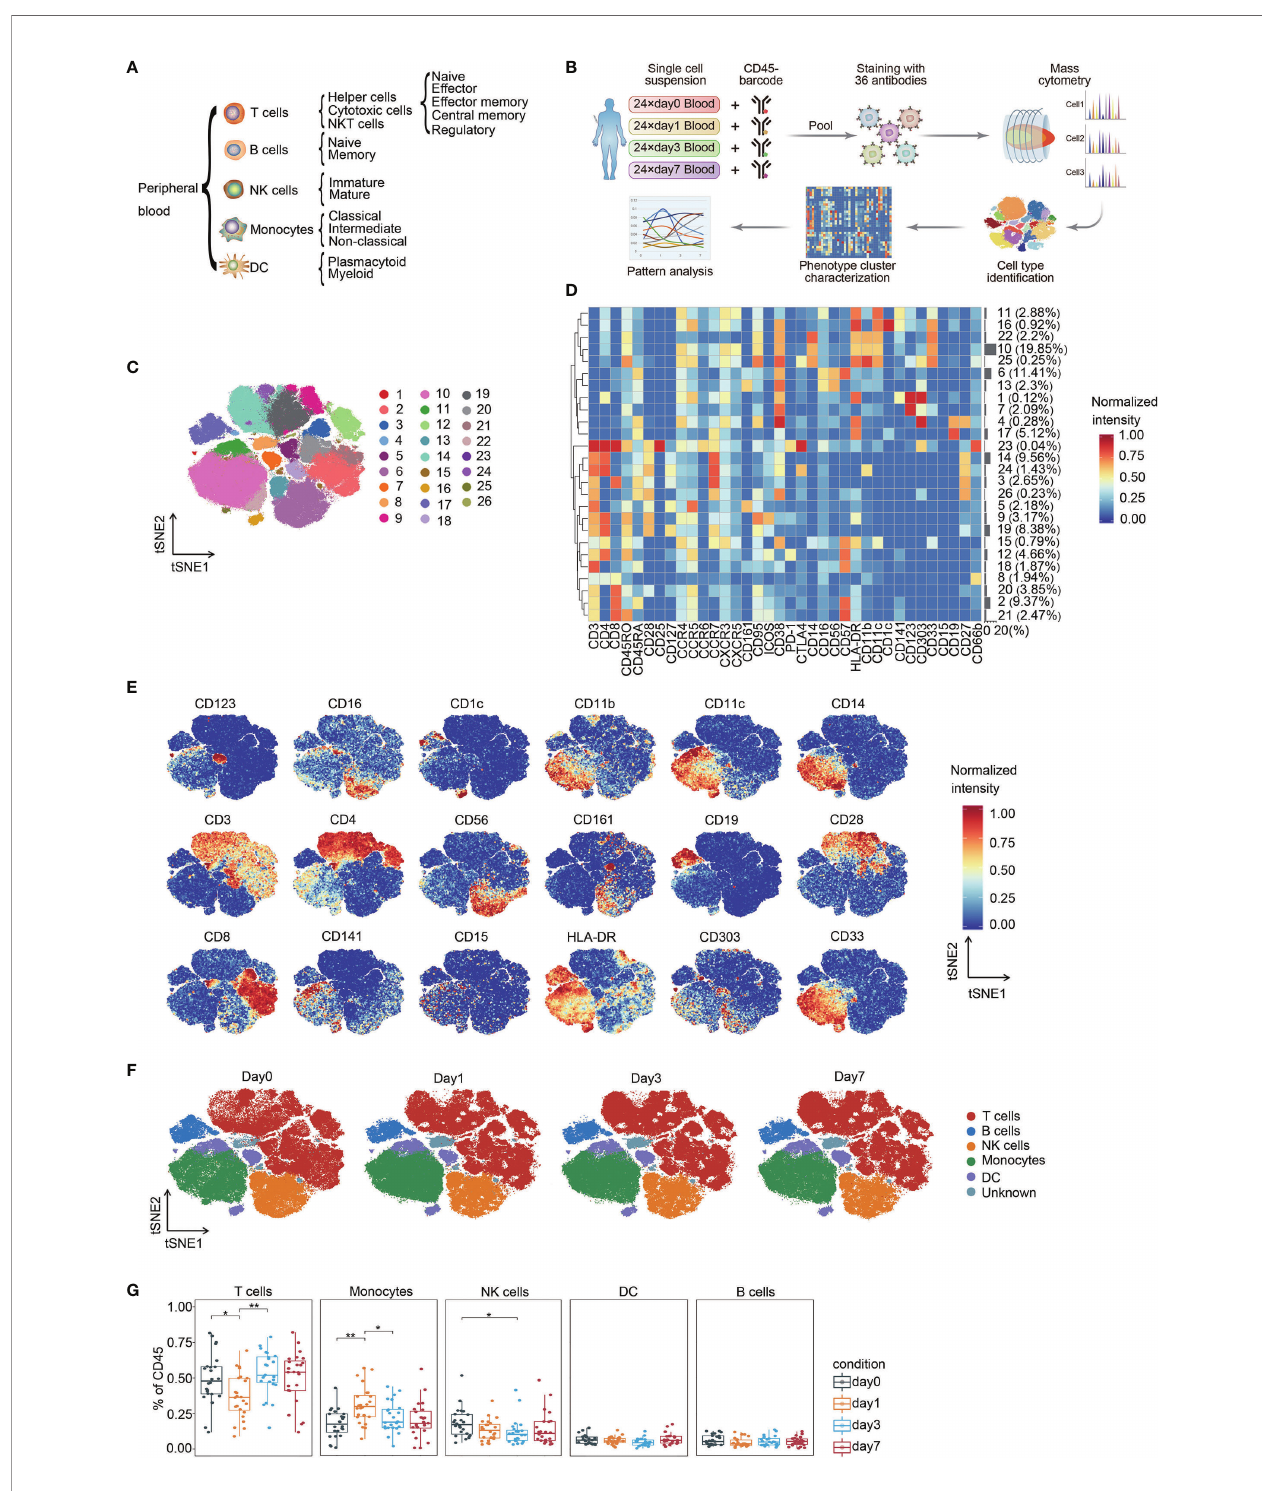
FIGURE 1 | Identi fi cation of the main immune components in CRC. (A) Immune cell lineages and respective subpopulations of interest for comprehensive immunophenotyping. (B) Experimental strategy used in this study. (C) FIt-SNE of immune cells colored by PhenoGraph clusters. (D) Heatmap showing the normalized expression of the markers for PhenoGraph clusters. Clusters are grouped by surface marker expression pro fi les. The cluster numbers and relative frequencies are exhibited on the right. (E) FIt-SNE plots of normalized marker expression for 10,000 cells randomly selected from all patients. (F) FIt-SNE plots highlighting the distribution of major cell lineages. (G) Boxplots showing the frequencies of each immune cell lineage at different time point. *p < 0.05, **p < 0.01 by Krustal-Wallis analysis with post- hoc Dunn test. P-value adjusted with the Benjamini-Hochberg method. NK, natural killer; DC, dendritic